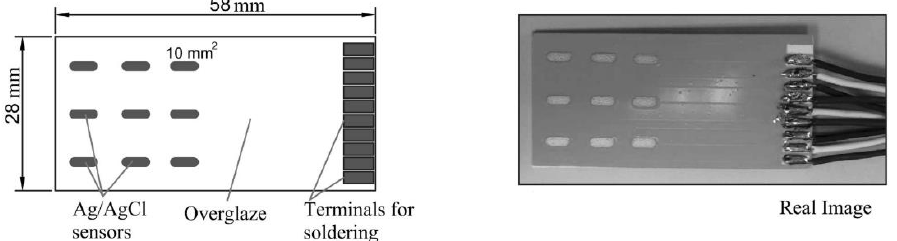
Figure 29. Design of a potentiometric chlorine sensor. ((Reprinted with permission from ref. [144]. Copyright 2016 Elsevier).